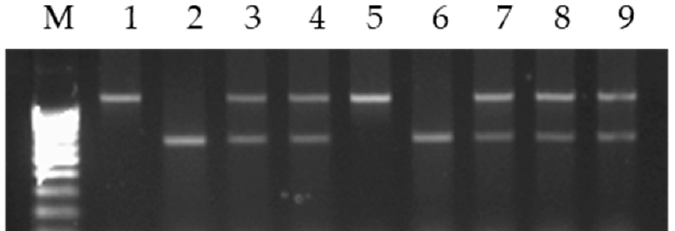
Figure 5. Multiplex PCR detection of 1BL.1RS translocation with a codominant marker. M: 100